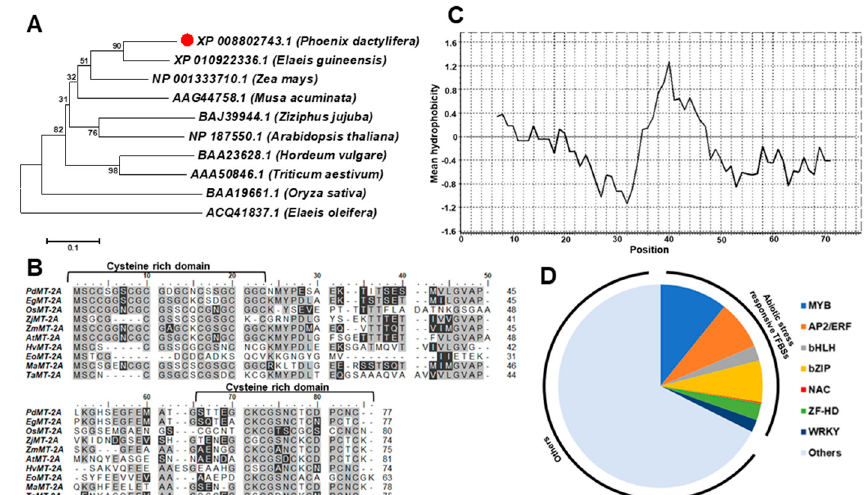
Figure 1. Sequence analysis of 10 metallothioneins (MT) amino acid sequences of various plant species and the phylogenetic tree constructed using the neighbor-joining method. The bootstrap values on the nodes represent percentages of 1000 repetitions ( A ). The multiple sequence alignment of the deduced amino acid sequence of PdMT2A and other MT2A isoforms from other plant species. The gray-colored highlighting represents identical and conserved regions and the dark highlighting represents similar regions with one amino acid difference. The two cysteine-rich domains are indicated at the N- and C-termini of the sequences ( B ). The hydrophobicity plot of each amino acid in the PdMT2A sequence according to the Kyte–Doolittle hydrophobicity scale ( C ). The sequence analysis of the putative 2000-bp promoter region upstream of the PdMT2A start codon, showing the abundance of abiotic-stress-related transcription factor binding sites (TFBSs) within the putative promoter sequence ( D ).